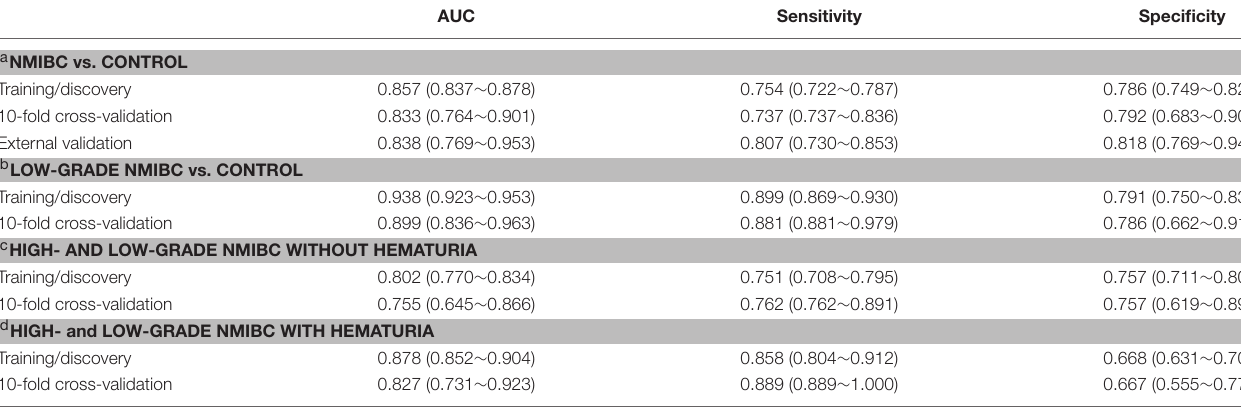
TABLE 2 | Performance of Logistic Regression Model for NMIBC